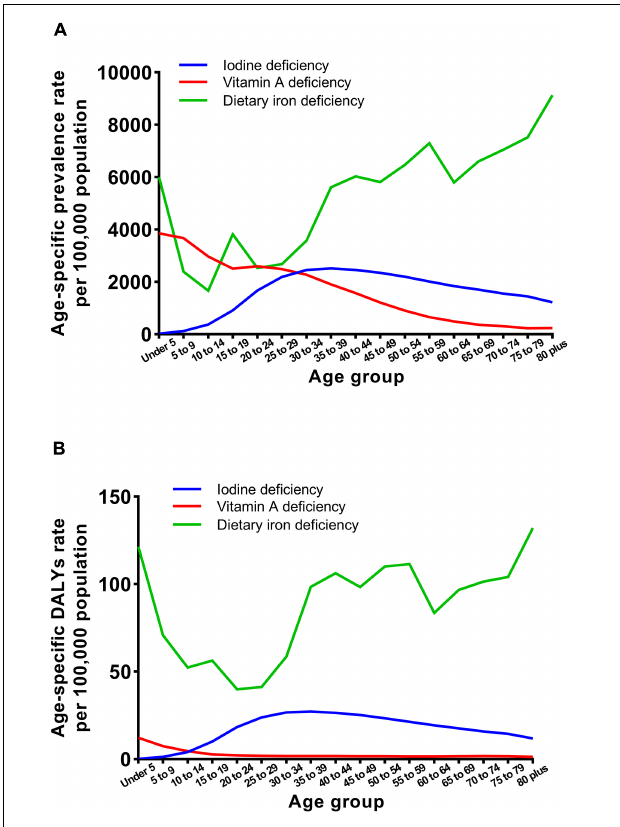
FIGURE 2 | Age-specific prevalence and DALY rates of iodine deficiency, vitamin A deficiency, and dietary iron deficiency in 2019. (A) Age-specific prevalence rate. (B) Age-specific DALYs